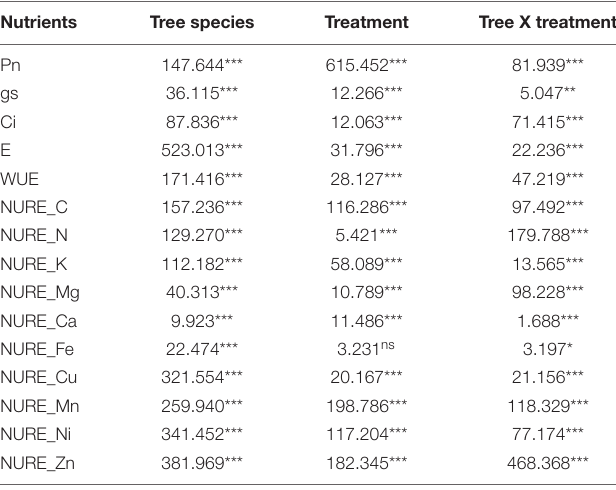
the considered tree species, and treatment and parts by